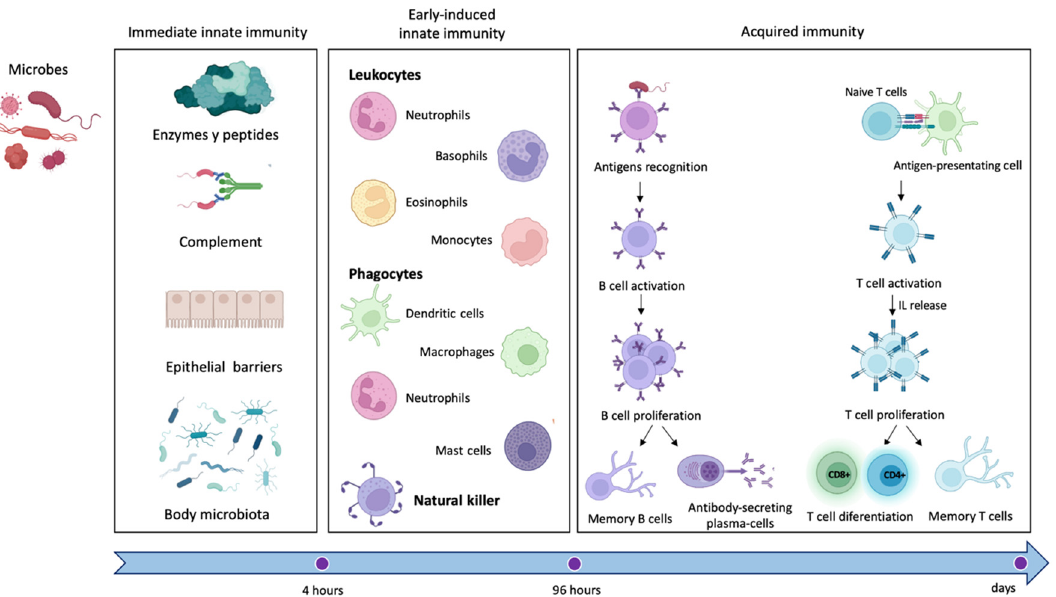
Figure 1. Immune response. Schematic representation of the key components of the innate (immediate and early induced) and the acquired response of the immune system. Immediate innate immunity is based on (1) the activity of circulating enzymes and peptides with anti-microbic action, including complement, (2) the integrity of the anatomic epithelia, and (3) the antagonism of resident host microbiota. Lately, early induced innate immunity is cell-dependent, modulated by the activity of leukocytes, phagocytes, and natural killer cells. Finally, adaptive immunity is lymphocyte-dependent: antigen is presented to B/T lymphocytes by antigen-presenting cells, which become active, proliferate, and differentiate into B cells producing antibodies, T cells CD4+ (T helper) or CD8+ (CTL, cytotoxic T lymphocytes) and B/T memory